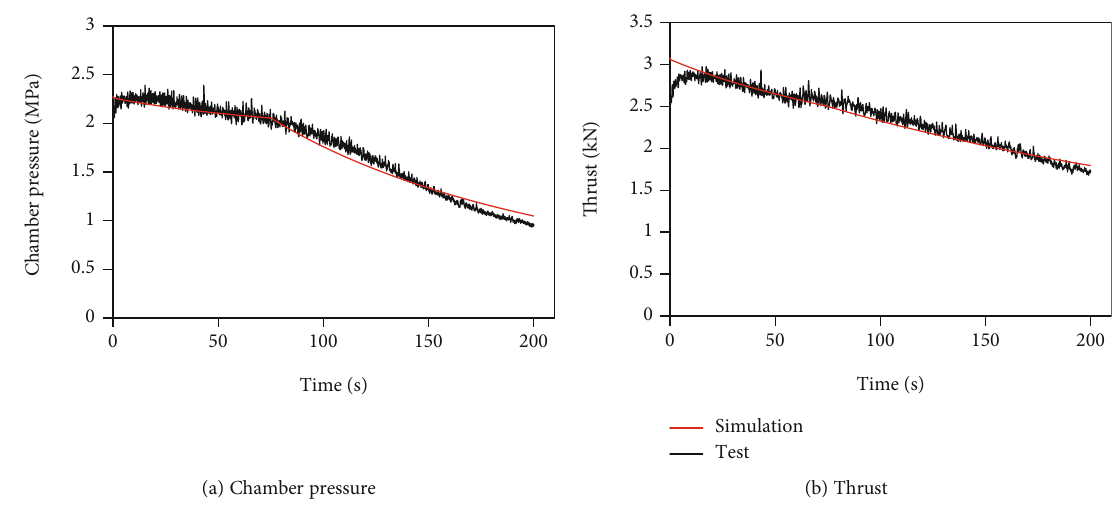
Figure 6: Experimental and predicted curves: (a) chamber pressure; (b) thrust. Table 2: Main structure of the SLV propulsion system.